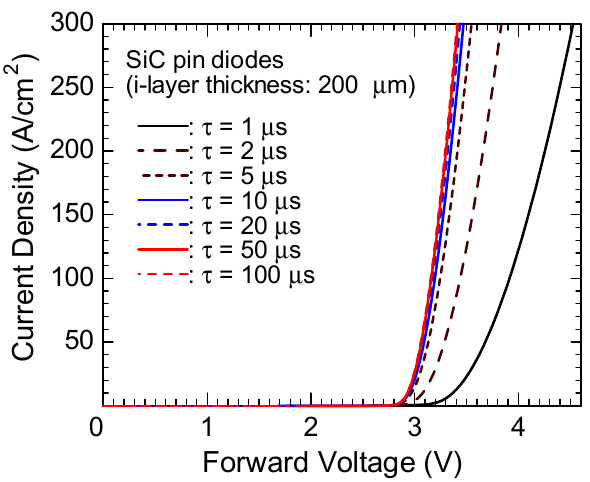
Figure 3. Forward characteristics of SiC pin diodes having an i-layer thickness of 200 µm (28 kV class). The carrier lifetime in the i-layer was changed from 1 µs to 100 µs.